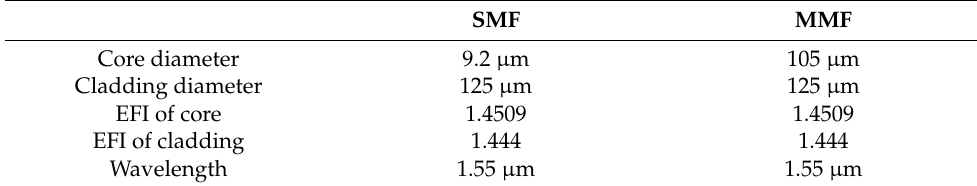
Figure 4. ( a ) Optical field distribution in the SM structure; ( b ) relative value of light intensity in the core of SMF and MMF. Table 1. Simulation parameters of SM